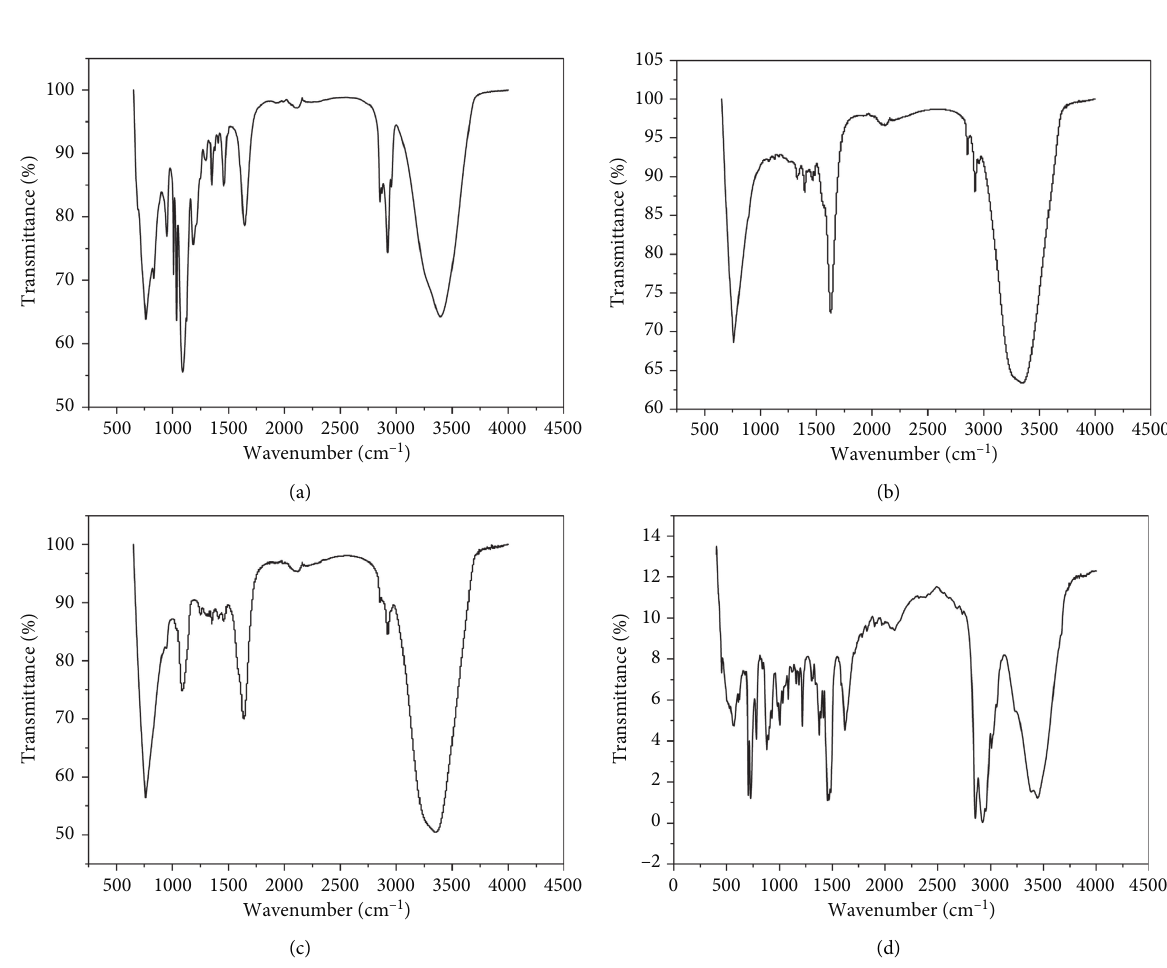
Figure 7: FTIR spectrum of surfactants. (a) FMEE. (b) BS-12. (c) AEC. (d)